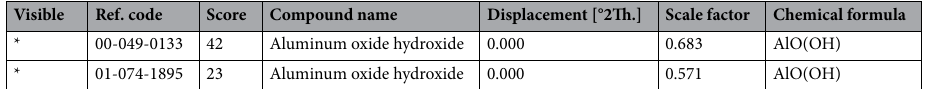
Table 1. Identified patterns list from XRD results of boehmite NPs (Aluminum Oxide Hydroxide).